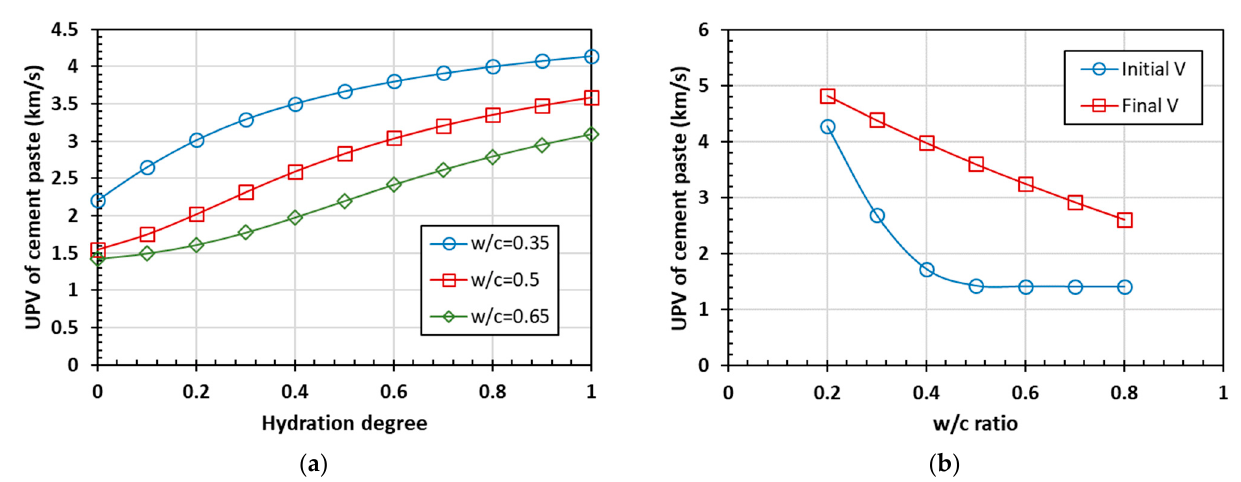
Figure 4. The ultrasonic pulse velocity prediction of cement paste: ( a ) hydration process and ( b ) the influence of the water-to-cement ratio. influence of the water-to-cement